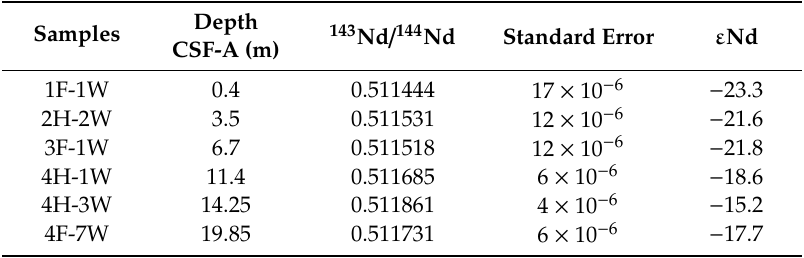
Table 1. Neodymium radiogenic isotope data at Hole